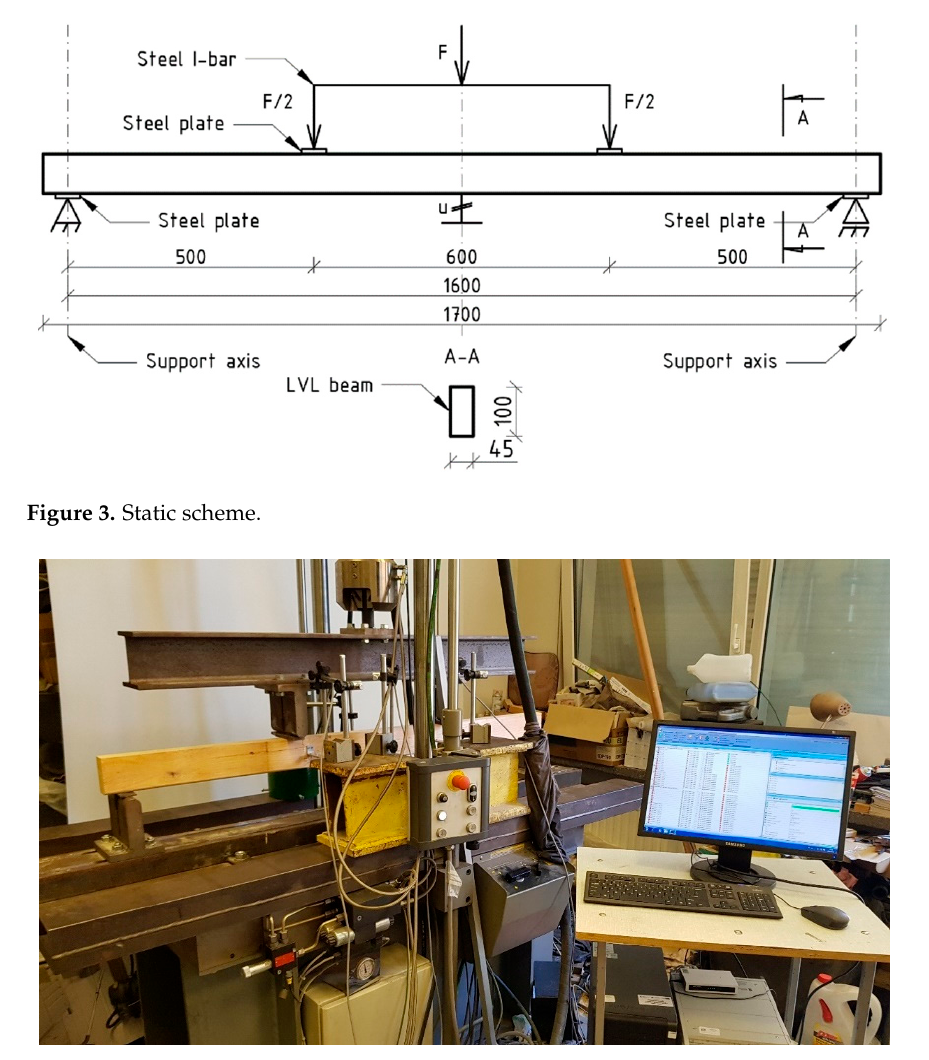
Figure 4. View of the test bench.